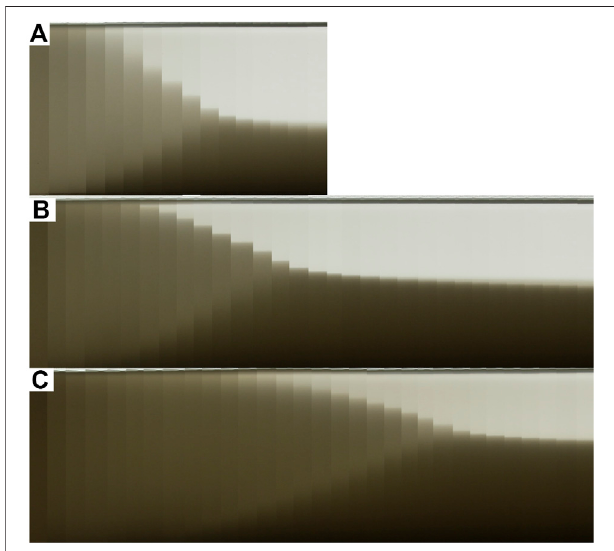
FIGURE 4 | Example of the settling process over time for (A) 4 ppt and 0.98 PSU for a total observation period of 7.5 h, (B) 6ppt and 0.75 PSU for a total observation period of 15.5 h and (C) 8 ppt and 0.62